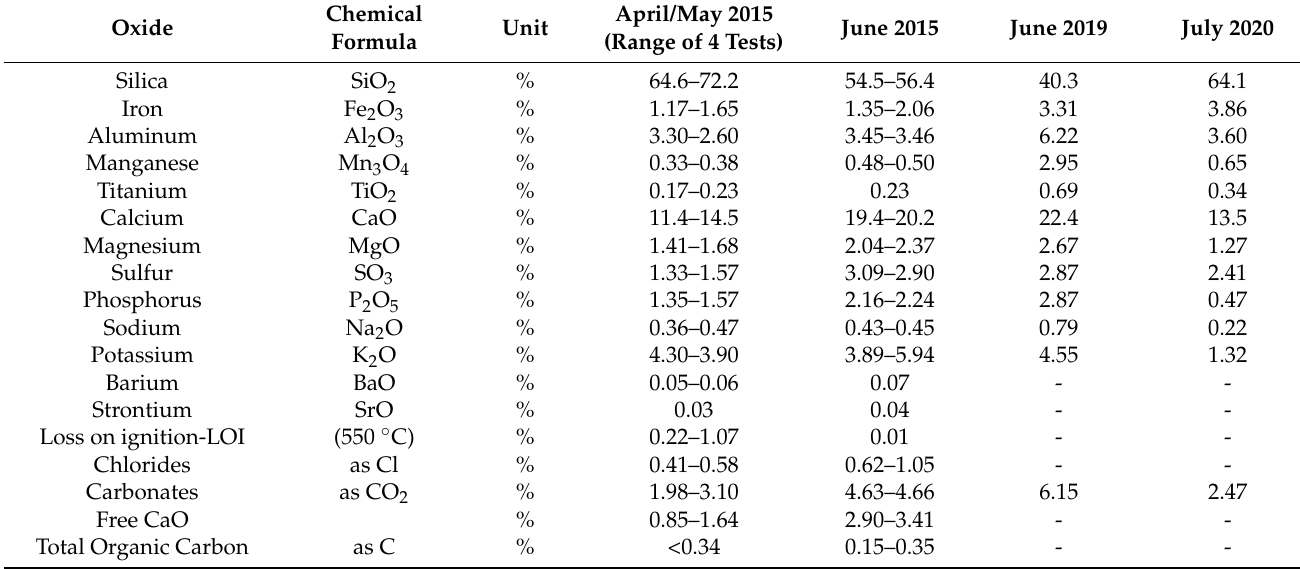
Table 1. Exemplary composition of fly ash from a biomass block, in %mass.